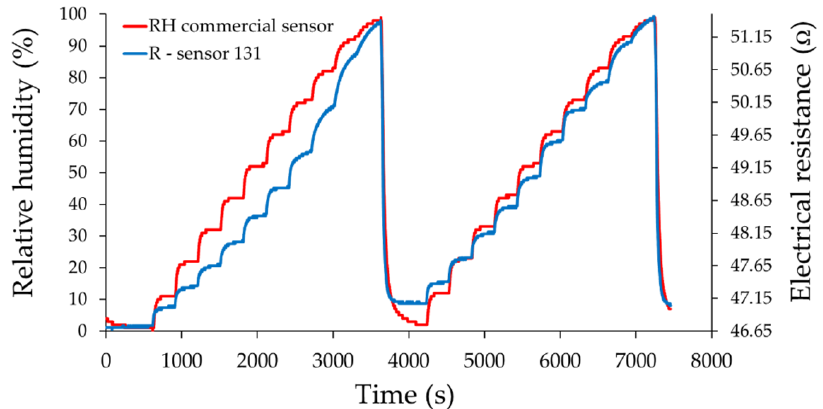
Figure 12. The response of the sensor 131 (“R curve”—blue) as a function of time for two measurement cycles, when relative humidity was increased in ten steps from 0% RH to 100% RH; “RH curve—red” shows the similar characteristic measured for a commercial, industrial sensor.